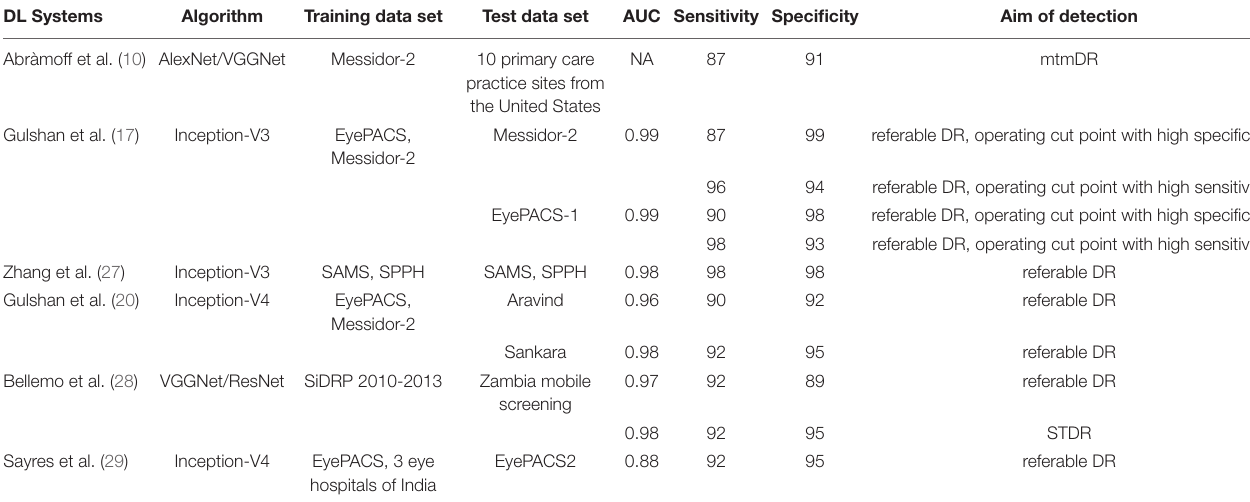
TABLE 5 | Several state-of-the-art deep learning models for DR